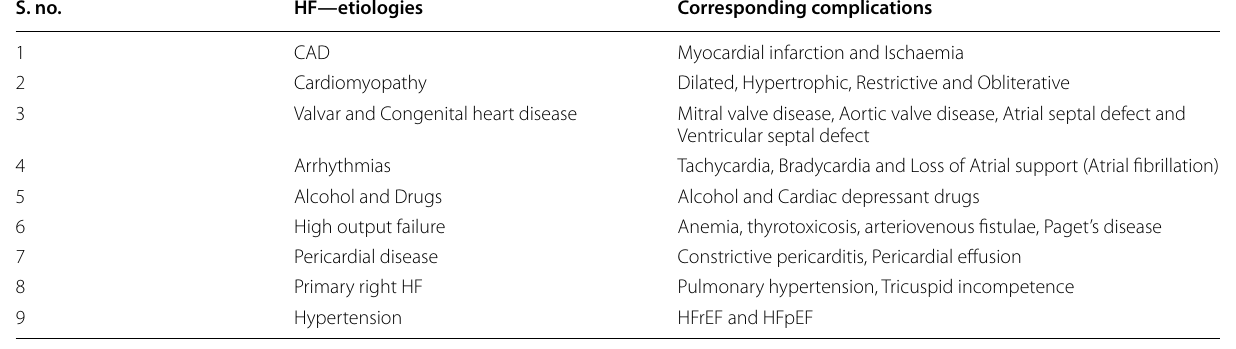
Table 1 Different HF etiologies and their complications [39–41] S. no.